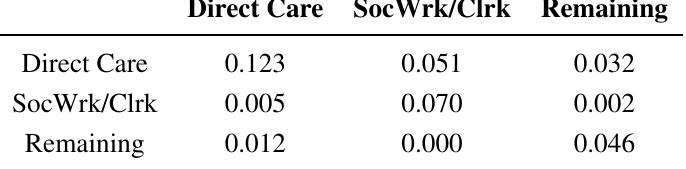
Table 5. The decrease in the number of individuals infected of the row group from vaccinating one additional individual from the column group. Thirty percent of the population is immune at the start of the epidemic, resulting in a lower marginal effect of vaccinations for all groups.